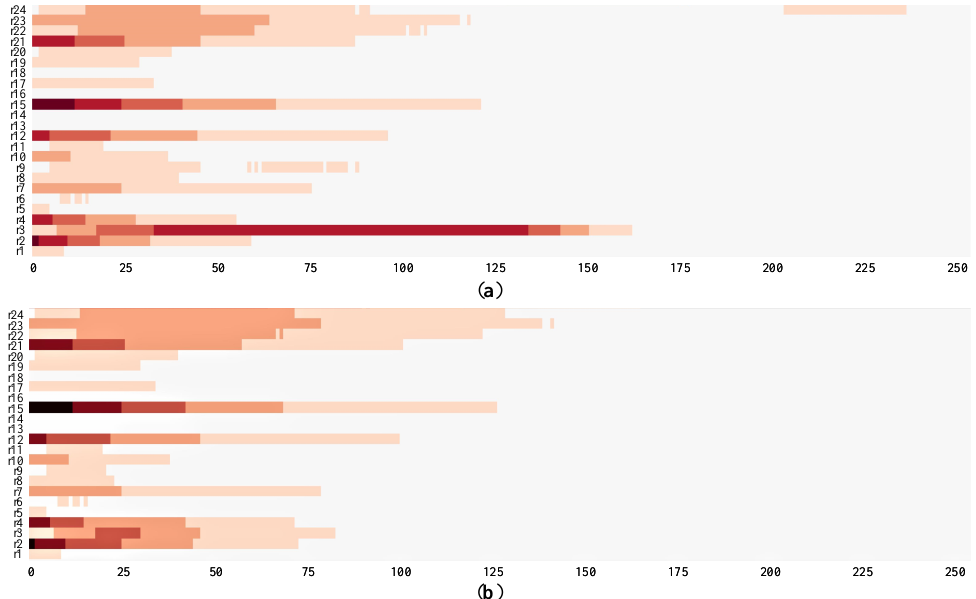
Figure 14. Heat map of the number of people in case of sudden fire at node T1 ( a ) a priori route strategy; ( b ) shortest evacuation time strategy.